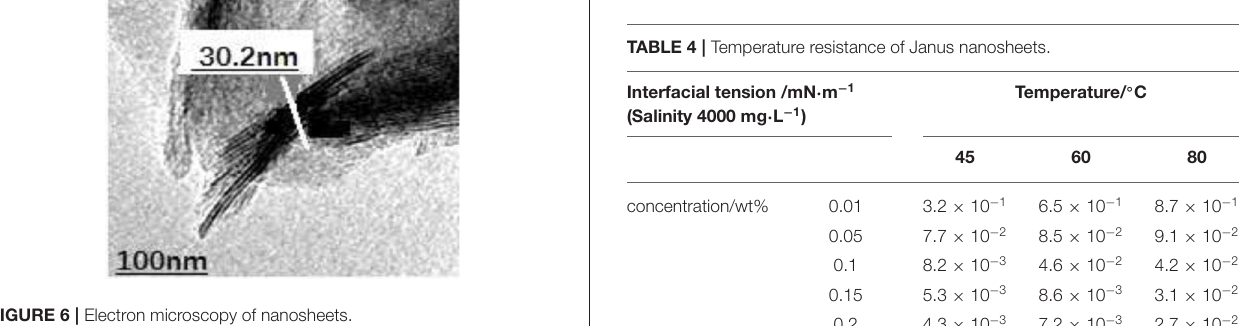
FIGURE 6 | Electron microscopy of nanosheets.